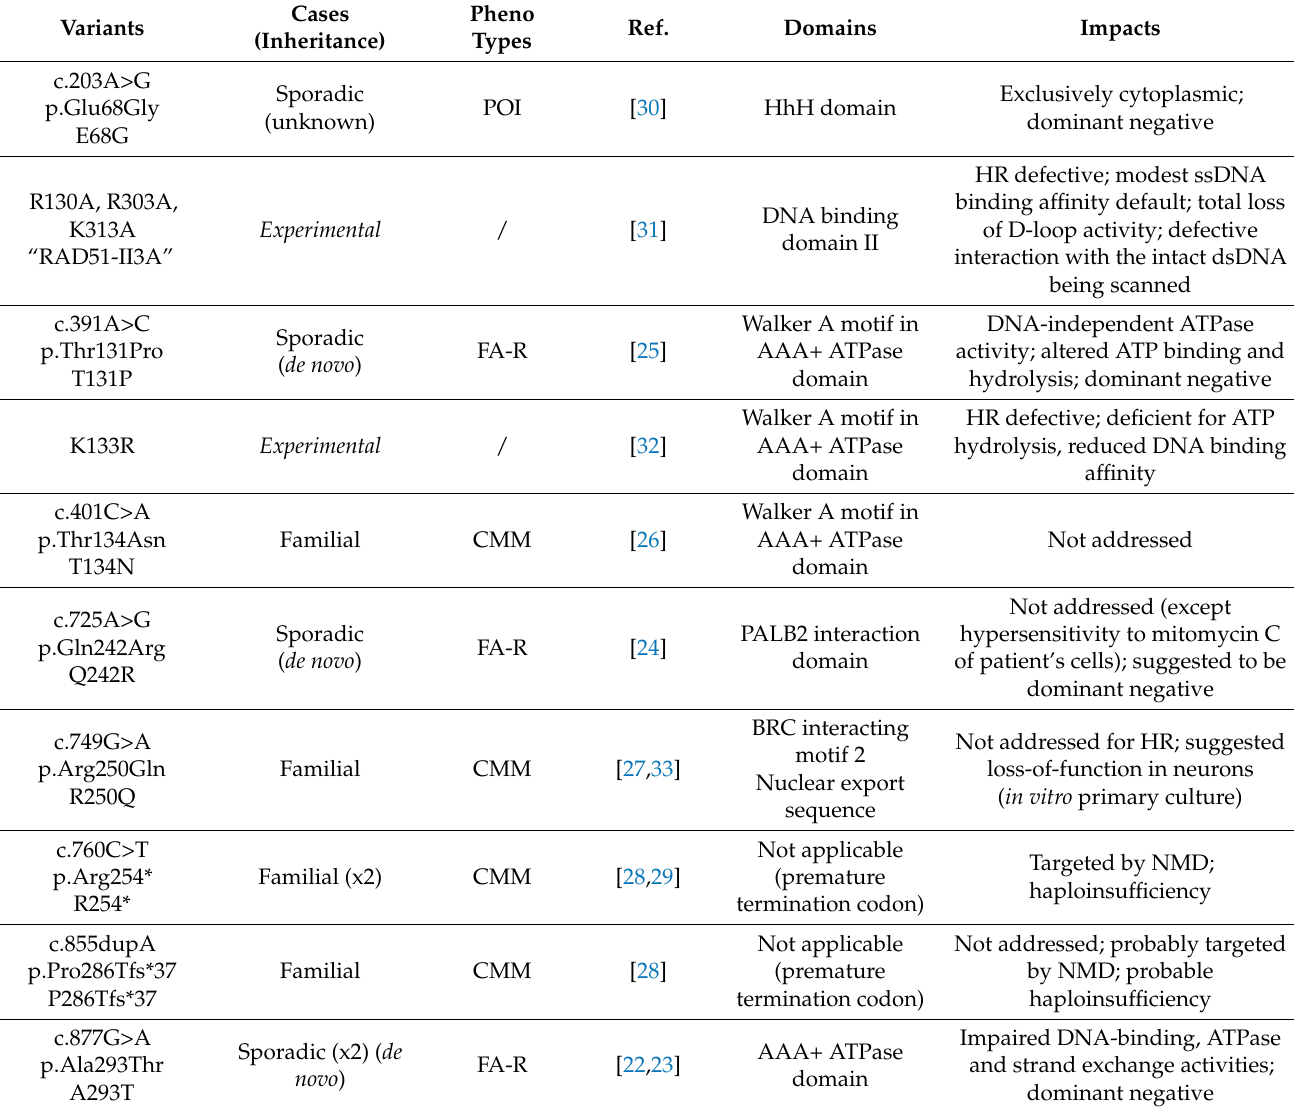
Table 1. RAD51 pathogenic or experimental variants (restricted to the coding sequence of RAD51 , ex- cluding the cancer/tumor-associated variants). All the RAD51 pathogenic variants are heterozygous. Phenotypes: congenital mirror movement (CMM), atypical Fanconi anaemia (FA-R), and premature ovarian insufficiency